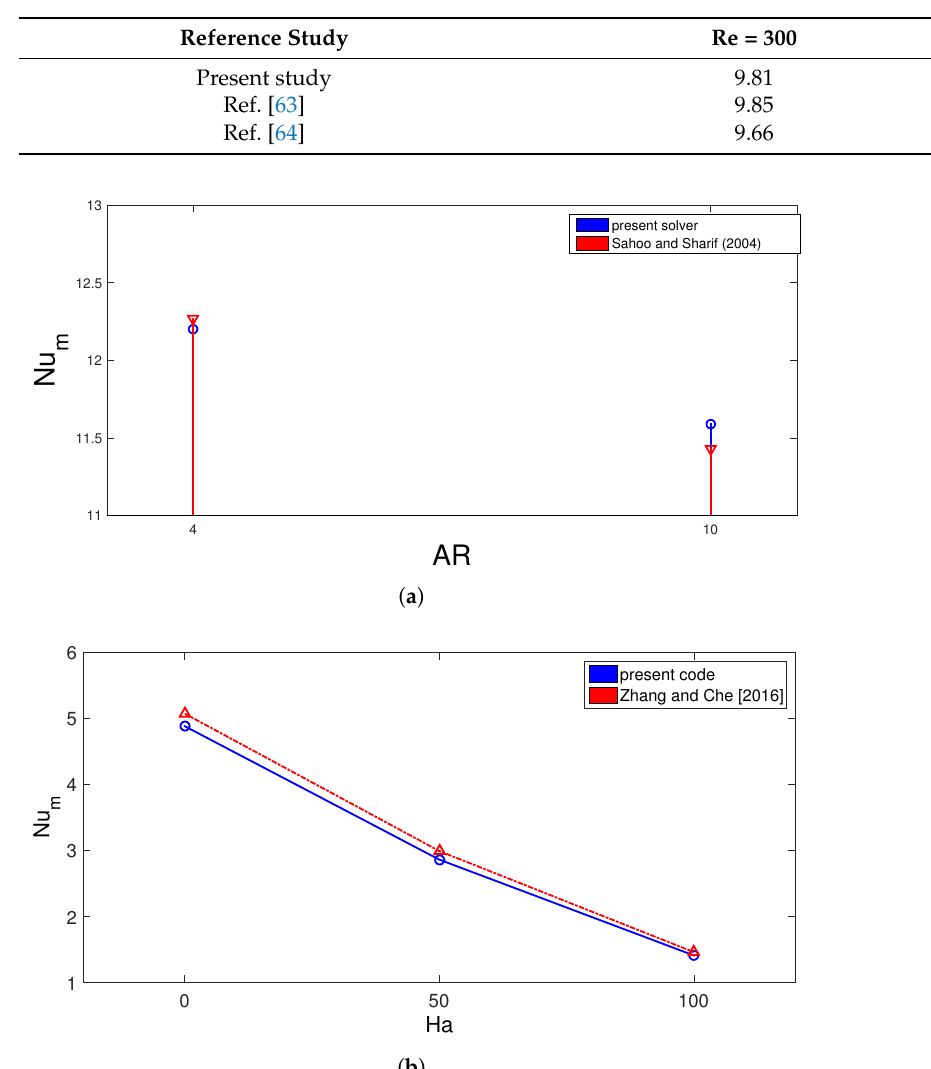
Table 1. Stagnation Nu comparisons for confined slot j-imp at Re = 300.